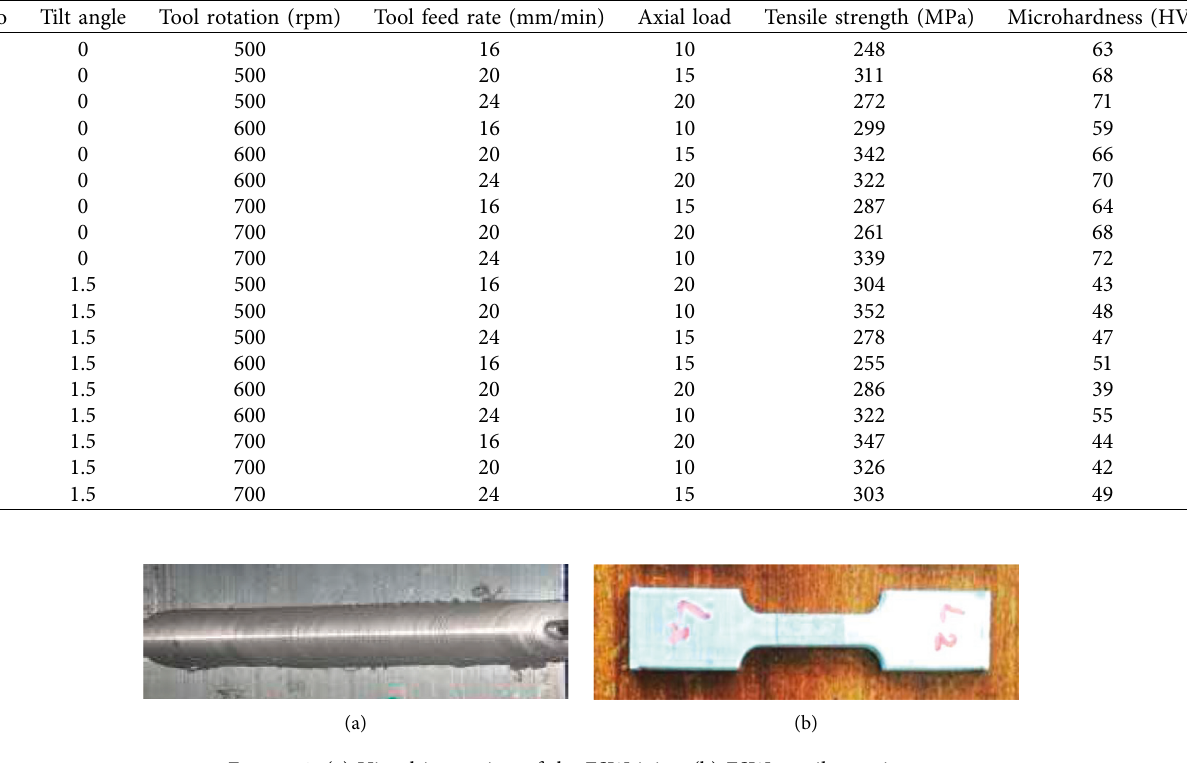
Table 2: Experimental runs and its results.